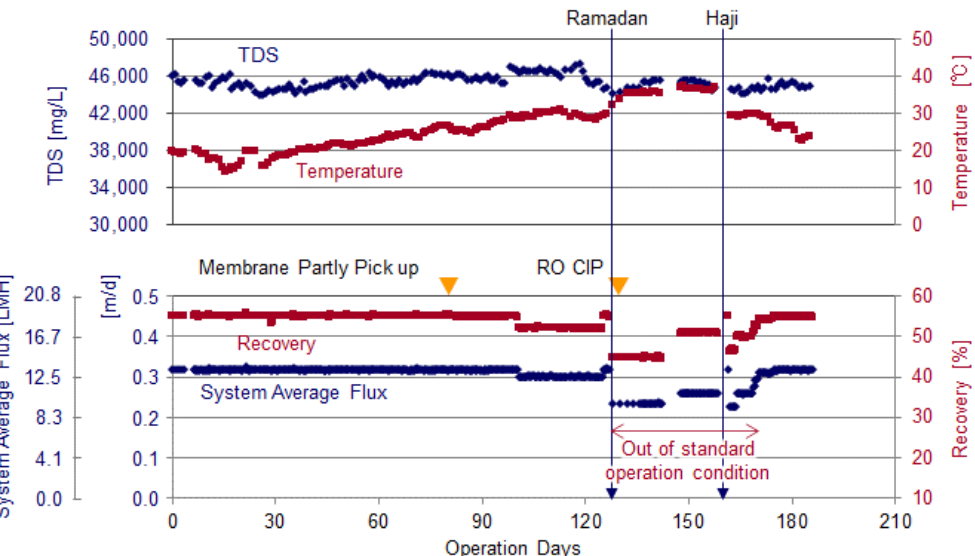
Figure 8. Dual media sand filtration (DMF) treated water quality and operation history.